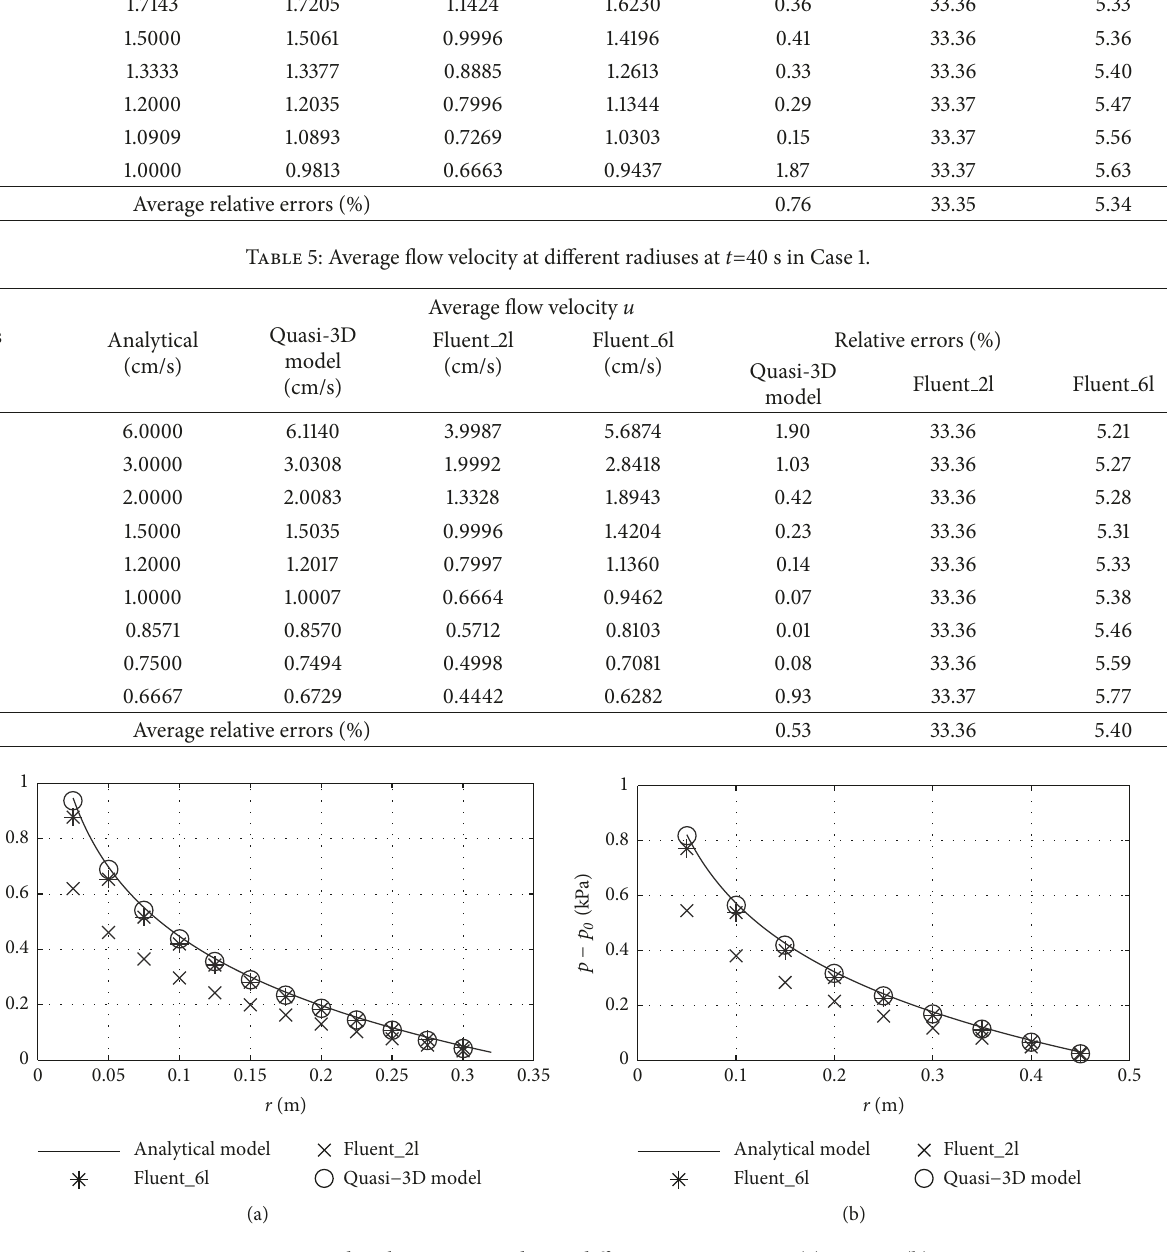
Figure 9: Grout pressure distribution over radius at different times in Case 1 (a) t = 20 s; (b) t = 40